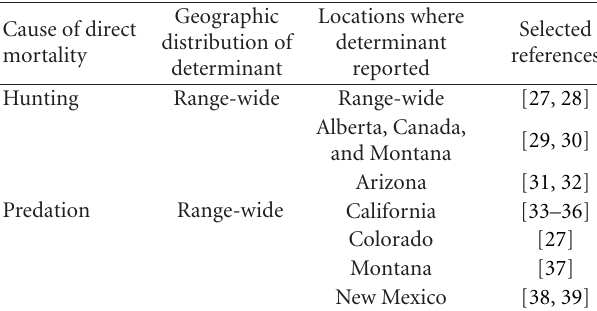
Table 1: Causes of direct mortality proposed to limit free-ranging bighorn sheep